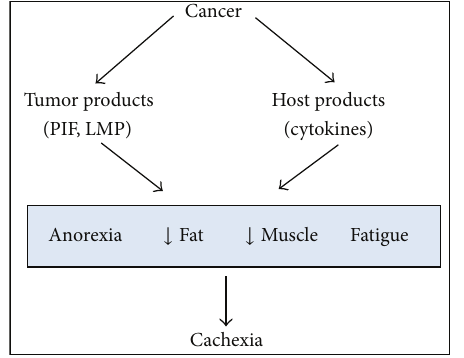
Figure 2: Emerging view of cachexia as proposed by Tisdale